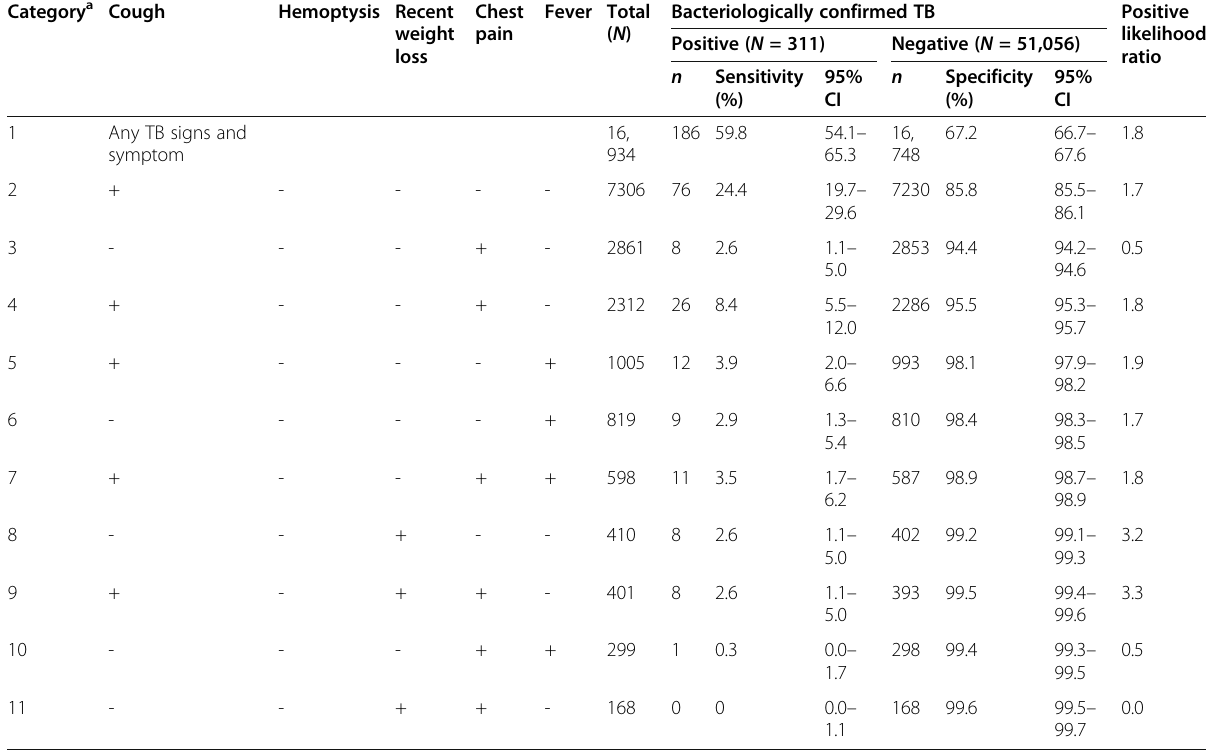
Table 2 Sensitivity, specificity, and positive likelihood ratio of various combinations of TB-SS by using bacteriologically confirmed TB as the gold